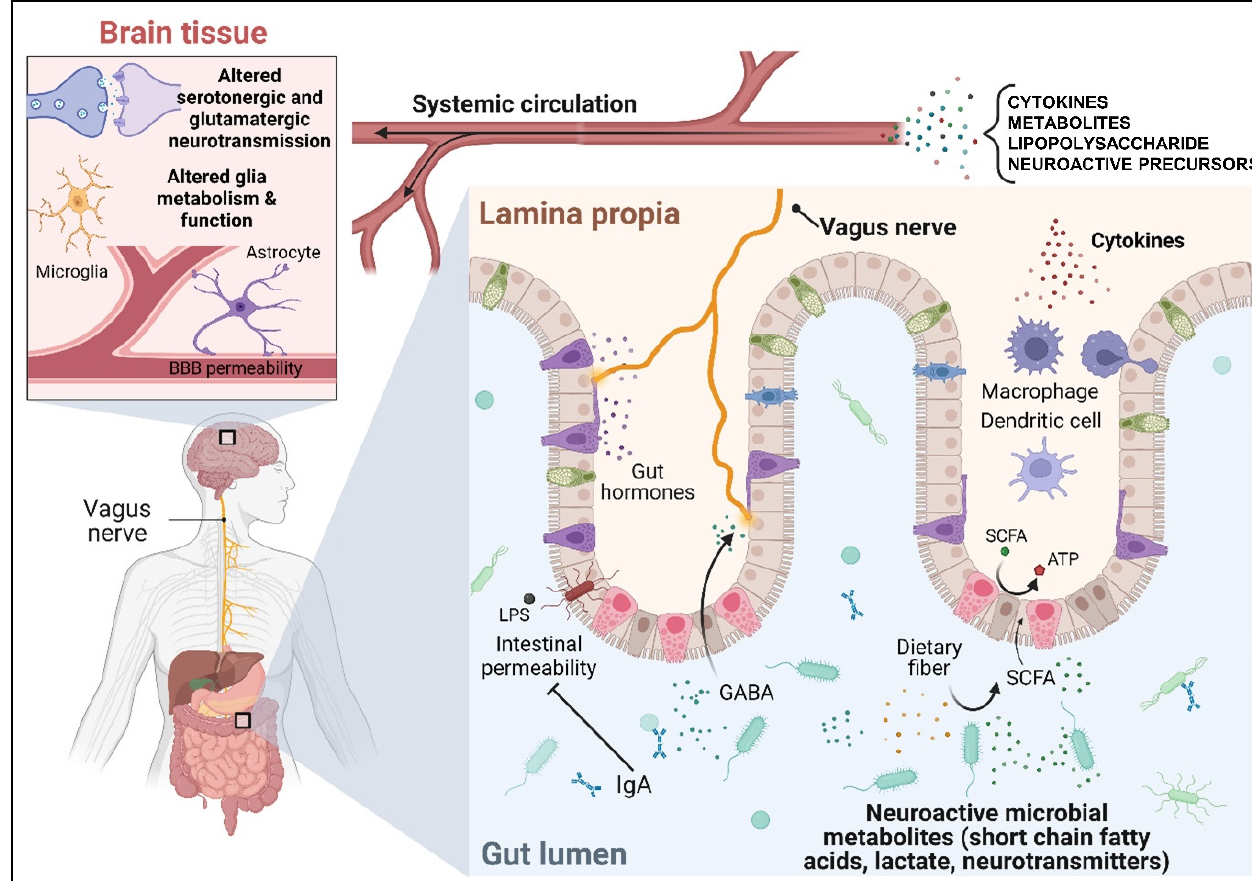
Figure 1. Summary of the putative mechanisms of communication between the gut microbiota and the brain.